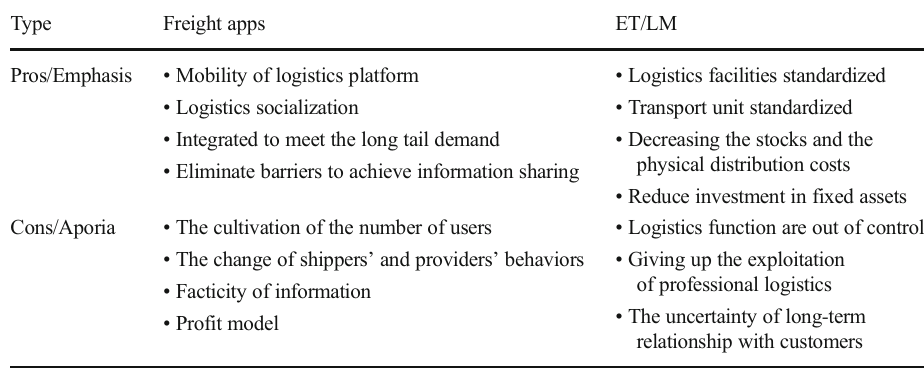
Table 2 A comparative between freight apps and ET/LM